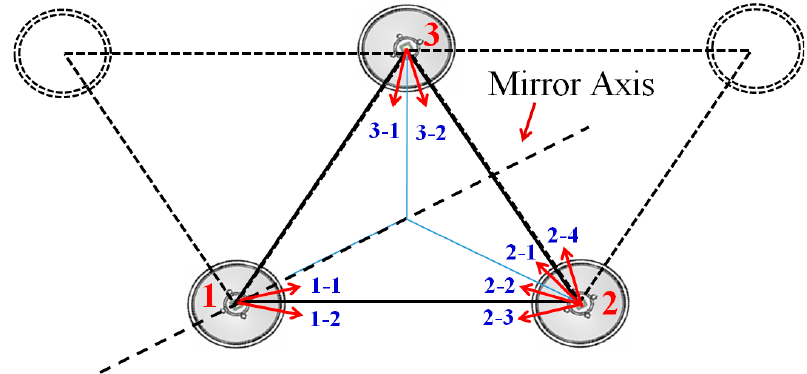
Figure 8. Schematic of the basic analysis model.